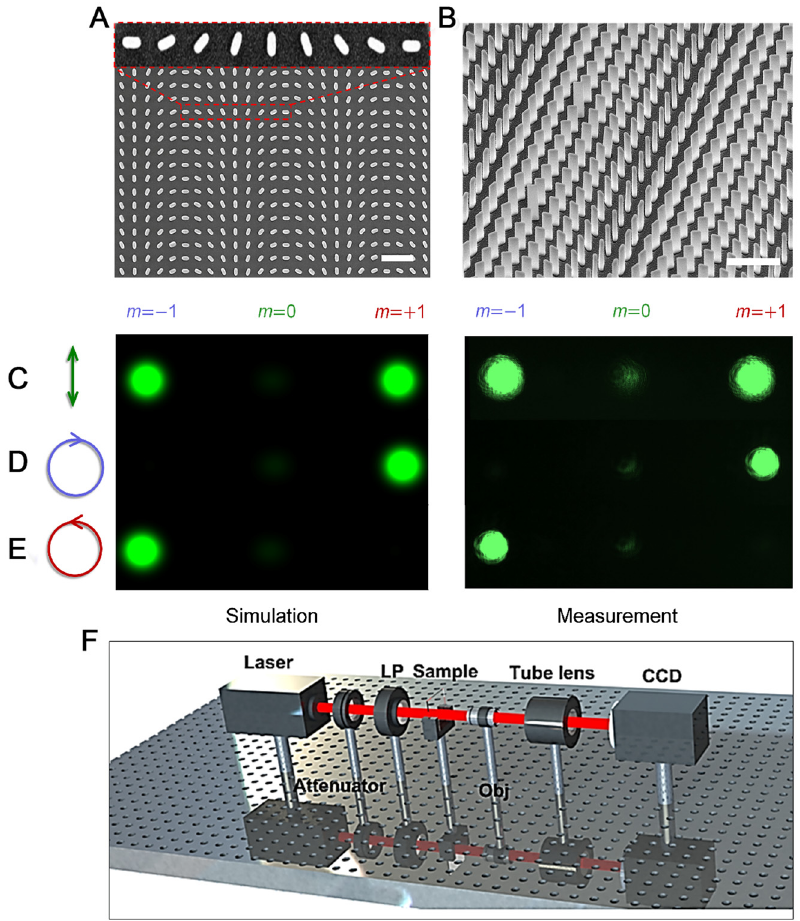
Figure 4: Fabricated titanium dioxide metasurface and comparison between simulations and measurements with different polarization states illumination at 514 nm. Scanning electron micrograph (SEM) of a fabricated metasurface, top (A) and side (B) view, and an enlarged image of the supercell is marked and inserted in (A) . Simulated and measured far- fi eld intensity pro fi les of m = − 1, m = 0 and m = + 1 orders with incident polarization states of (C) LP, (D) RCP and (E) LCP, respectively. (F) Optical measurement setup for the metasurface, consisting of a laser with desired wave- length whose beam is passing through a linear polarizer and a quarter-waveplate to generate the input light with desired po- larization to illuminate the metasurface, andthe transmissionlight is measuredby a charge-coupled device (CCD) camera. Scale bar: 1 μ